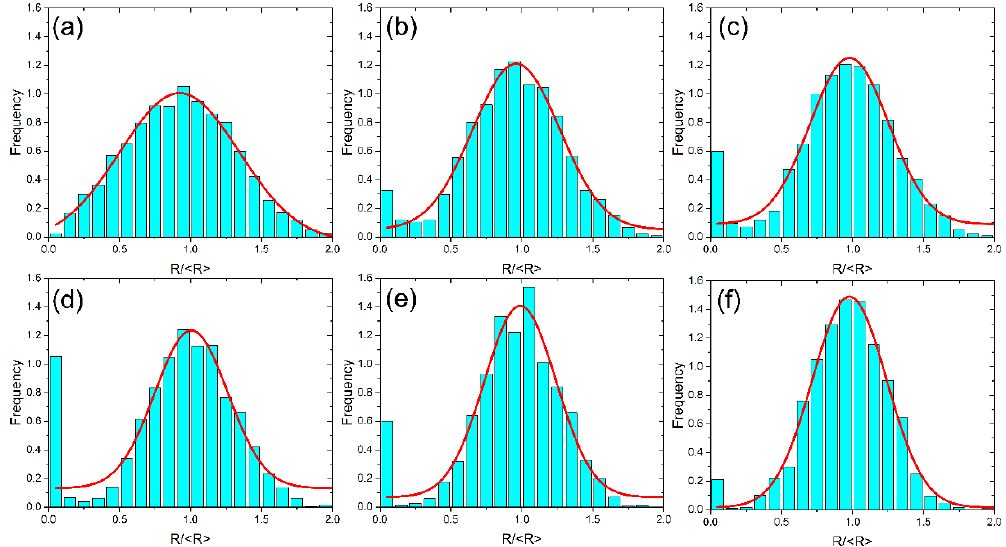
Figure 5. Particles size distributions at different times for the early stage in f v = 90% coarsening phase system. ( a ) t = 0 s; ( b ) t = 2 × 10 2 s; ( c ) t = 4 × 10 2 s; ( d ) t = 1 × 10 3 s; ( e ) t = 2 × 10 3 s; ( f ) t = 5 × 10 3